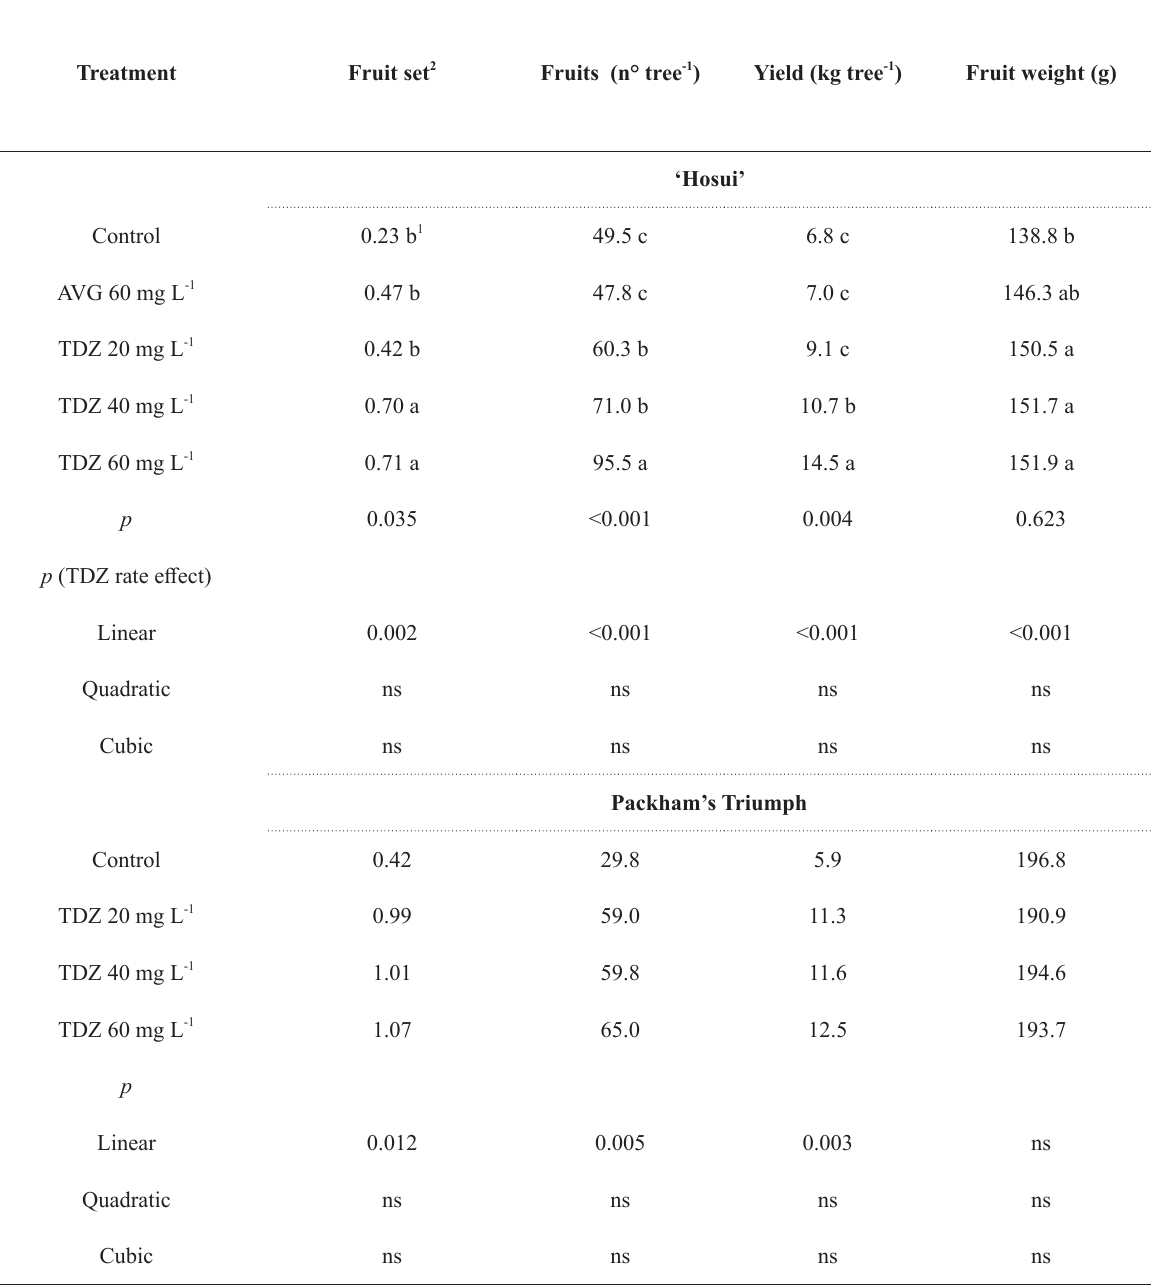
The effect of thidiazuron (TDZ) and aminoethoxyvinylglycine (AVG) on yield componentes of ‘Hosui’ and